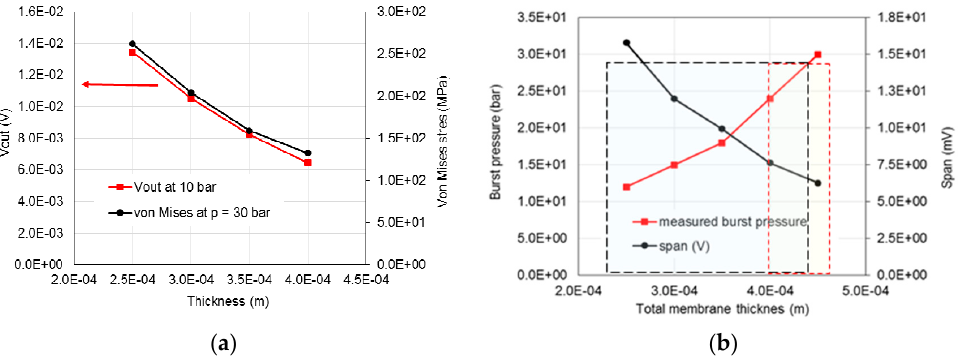
Figure 13. ( a ) The simulated characteristics of the sensor (at 25 °C) dependent on the total thickness of the diaphragm; ( b ) simulated span and measured burst pressure.